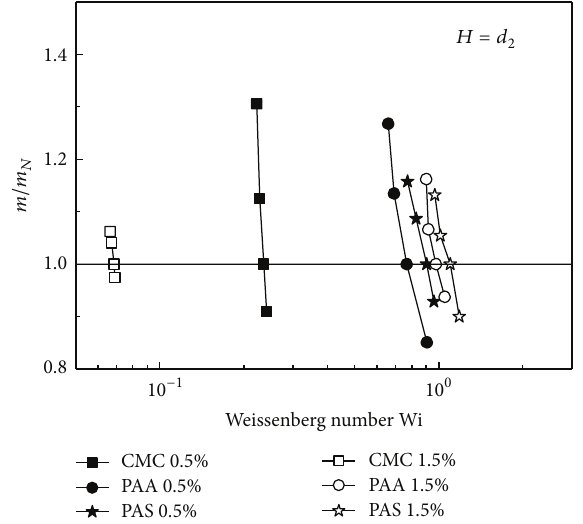
Figure 13: Increase of fractional coverage 𝑚/𝑚 𝑁 as a function of Weissenberg number Wi when sudden contraction tube angle is 𝜃 = 45 ∘ , 𝑄 = 600 mL/min and 𝐻 = 𝑑 2